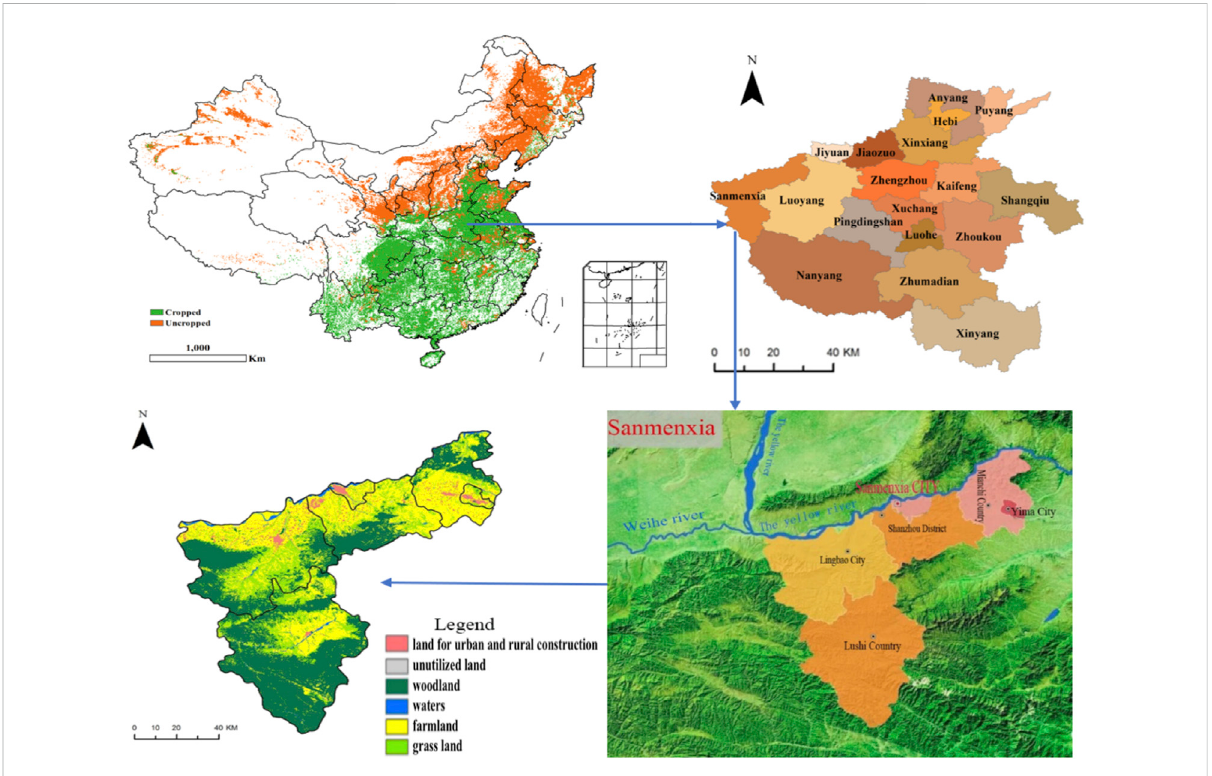
FIGURE 2 Location map of Sanmenxia City. (source from: National Earth System Science Data Center of the Chinese Academy,